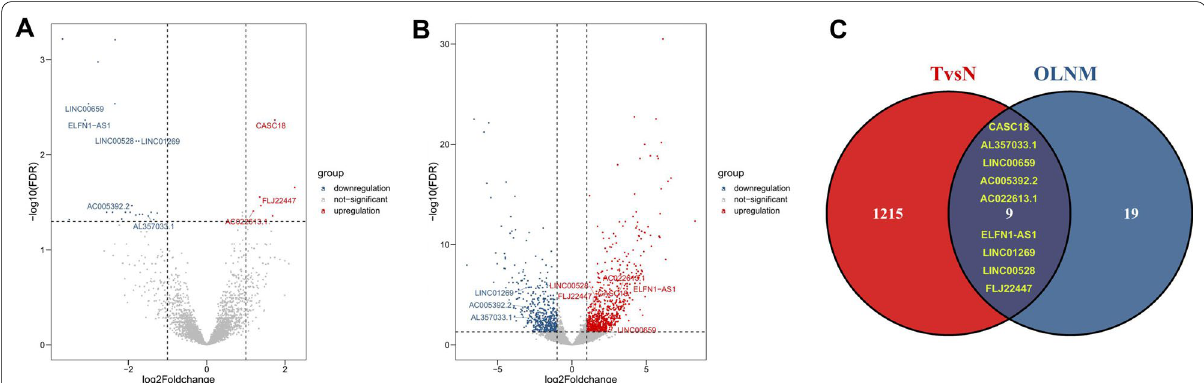
Fig. 1 Identification of lncRNAs differentially expressed in tumors derived from TSCC patients with OLNM. Volcano plots exhibit DEGs A in TSCC tumors as compared with the normal tissues, and in B tumors derived from TSCC patients with or without OLNM, with the symbols of differentially expressed lncRNA indicated. Red color meant up-regulated genes, and the blue color meant down-regulated genes. C Schematic illustration exhibiting overlap of differentially expressed lncRNAs. Red represents differentially expressed lncRNAs related to TSCC, blue represents differentially expressed lncRNAs related to OLNM, and the overlapping area represents the commonly changed